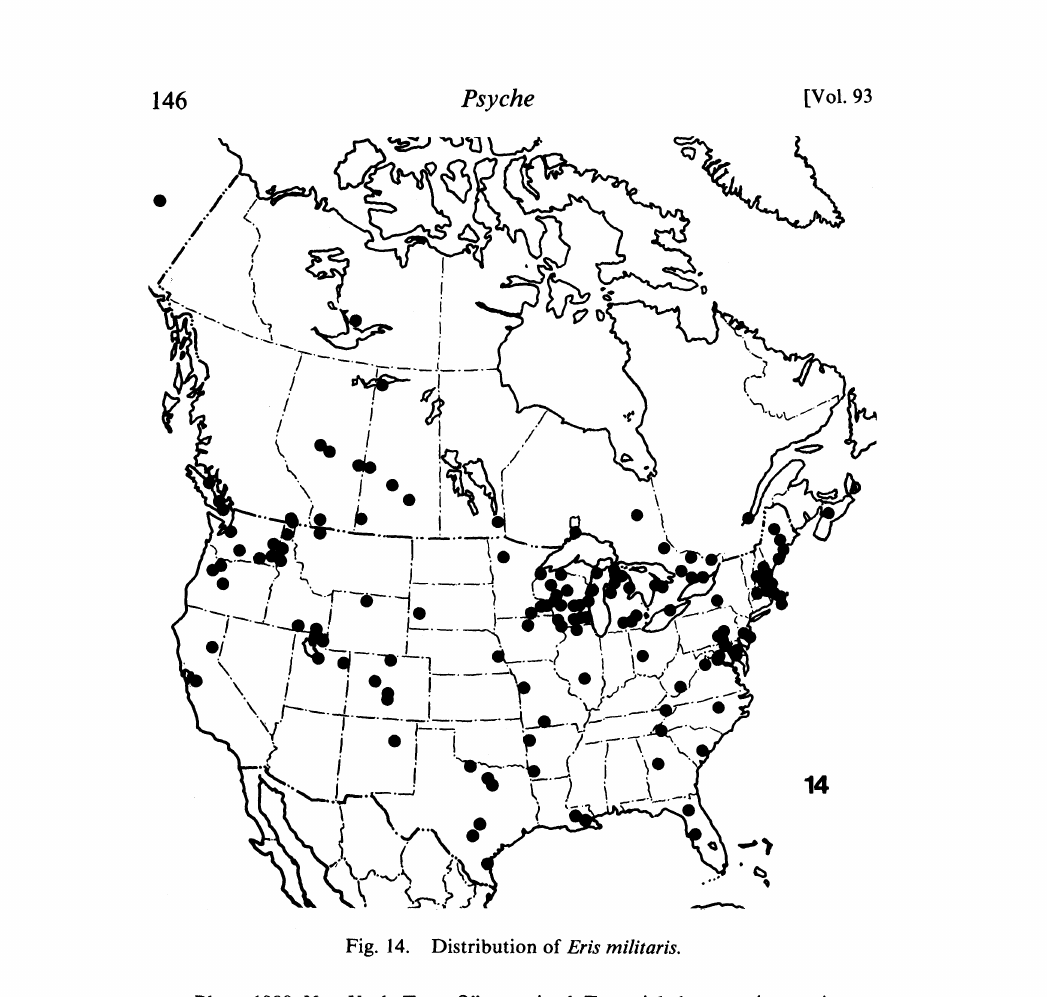
Fig. 14. Distribution of Eris